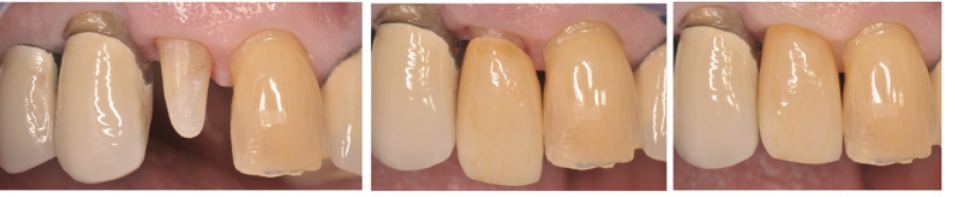
Figure 4. Surgical extrusion of 1.2 tooth with insufficient ferrule effect. Prosthetic rehabilitation.